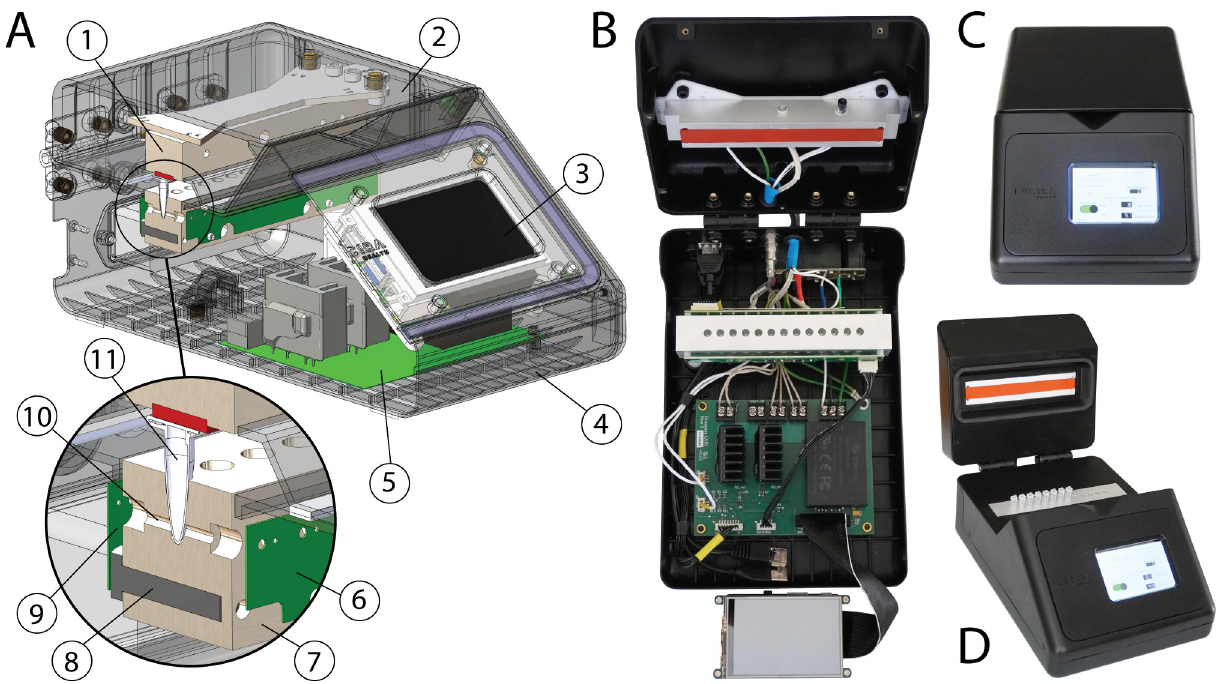
Fig 1. LARI mechanical design. (A) CAD cross section of LARI: (1) A Lid heating block, (2) Lid housing, which is hinged to the base housing, (3) Raspberry Pi single-board computer with LCD touchscreen interface, (4) Base housing, (5) Main control PCB, (6) Sensor PCB, (7) Tube heating block, shown in cross-section through a tube pocket and cartridge heater, (8) Cartridge heater, (9) LED PCB, (10) Through-holes in heating block allow light transmission from the LEDs, through the sample tubes, and on to the sensors, (11) Sample tubes are loaded into machined pockets in the block. (B) LARI shown with the housing open. All components are visible including the lid and tube heating blocks, PCBs, Raspberry Pi/touchscreen, and cabling. (C) Fully assembled LARI with lid closed. (D) Fully assembled LARI with lid open, showing sample tubes loaded.